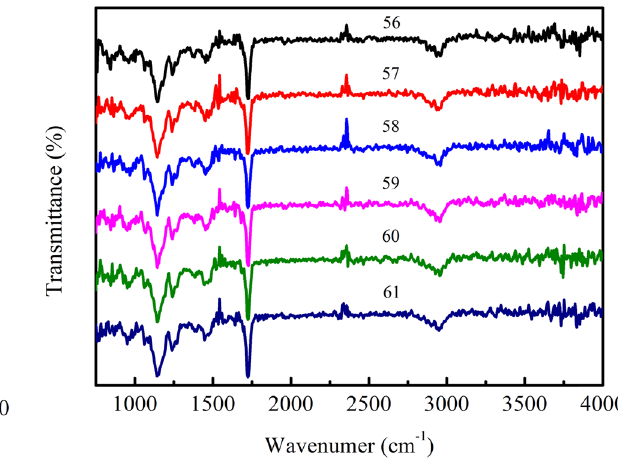
Figure 1: IR spectra of epichlorohydrin - modi fi ed thermosetting resins with di ff erent cured modes.